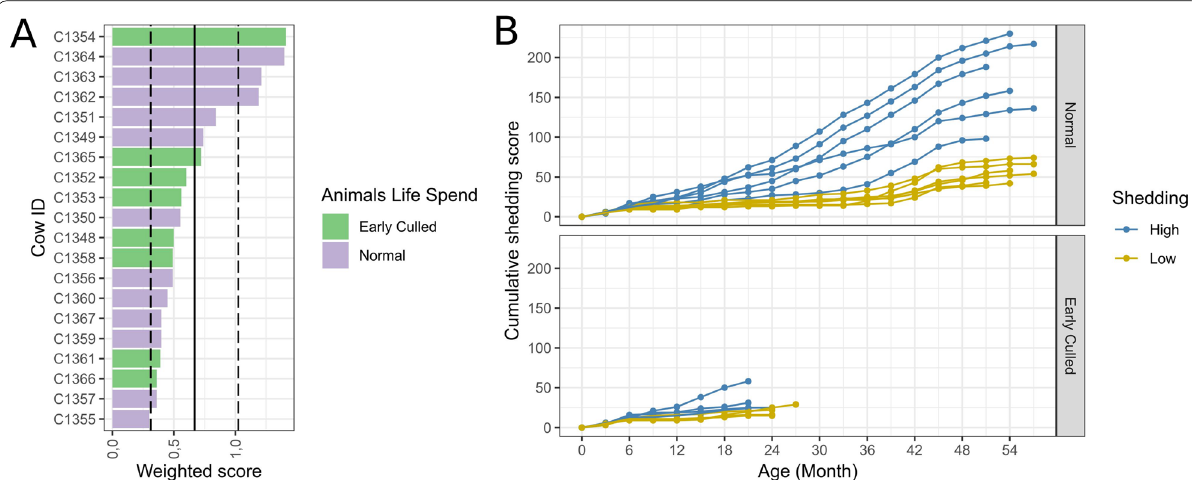
Fig. 2 A Bar chart of Weighted shedding intensity scores (SIS). The solid blue line marked the average weighted SIS and dashed lines marked 0.5 of Standard deviation. B Line/scatter plot of cumulative shedding values. Each dot represents the sum of shedding scores prior and including this time point. Lines and dots are coloured by shedding status that was assigned based on optimal separation by RF classification model (See “Results”: “General” RF classification